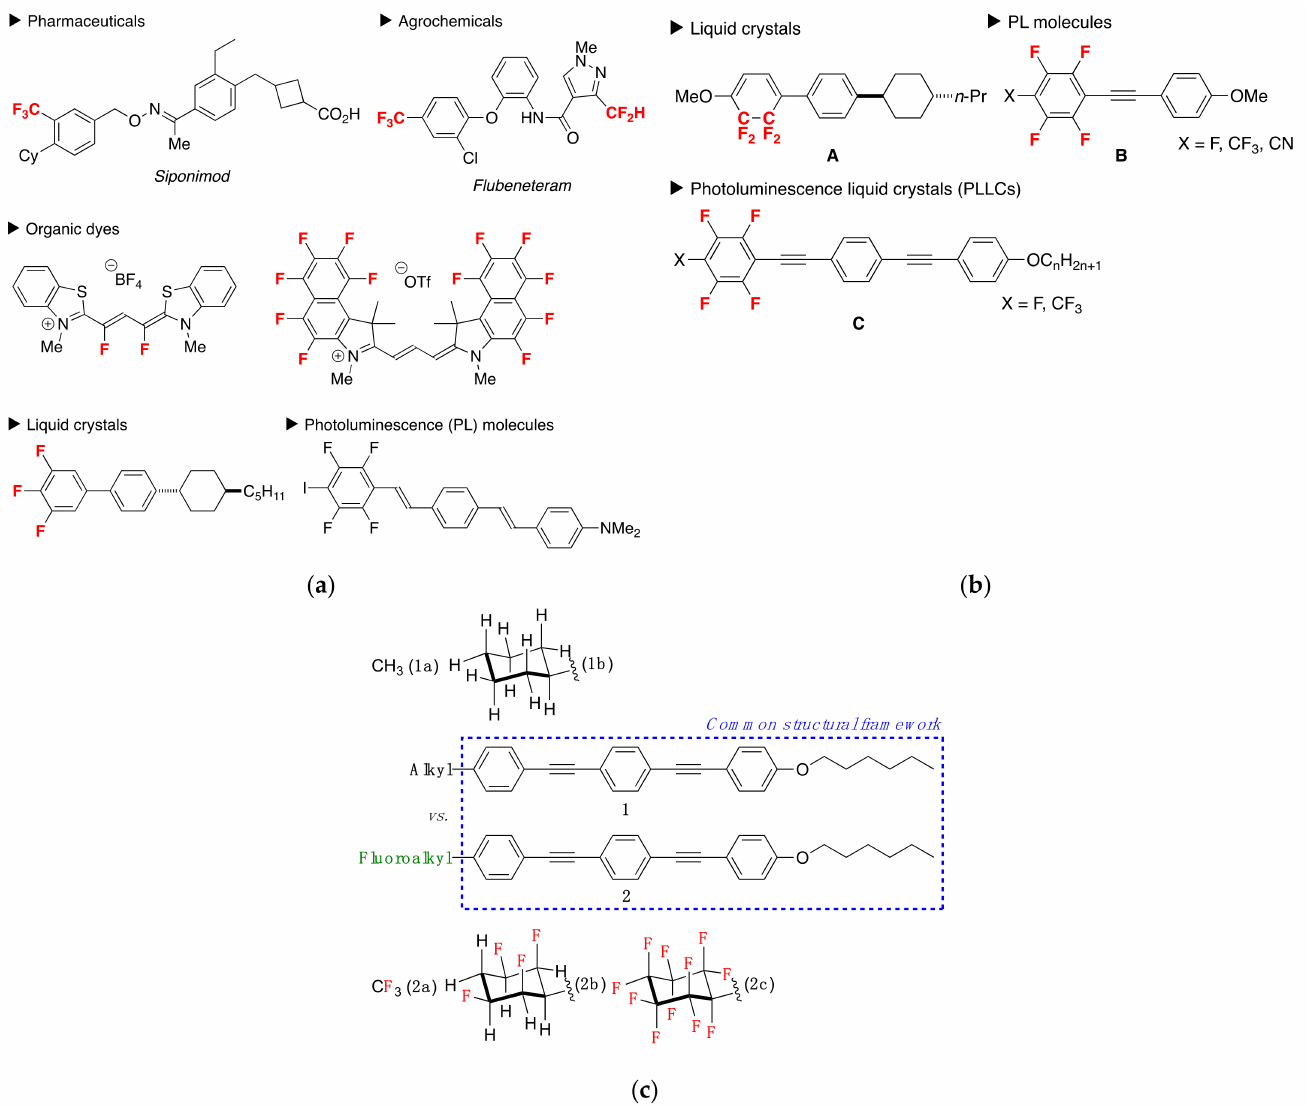
Figure 1. ( a ) Examples of fluorine-containing organic materials reported by other groups, and ( b ) by our group; ( c ) chemical structures of bistolanes 1 (bearing an alkyl chain) and 2 (bearing a fluoroalkyl